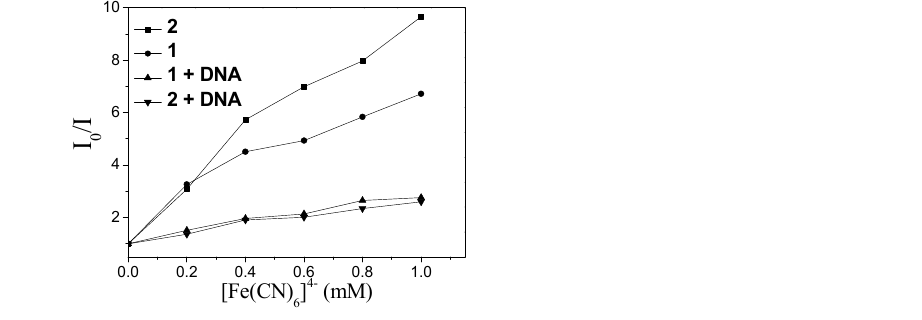
constants calculated were 4.38 × 10 5 M − 1 and 5.42 × 10 5 M − 1 for 1 and 2 , respectively. The K app values were similar to those obtained from absorption titration results.